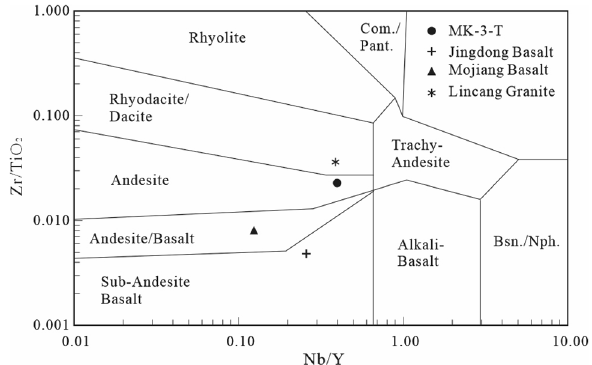
Figure 9. Zr/TiO 2 vs. Nb/Y shows typical volcanic rock types (modified after reference 51 ). The original lithology of the sample is andesite tuff ( Com comendite, Pant pantellerite, Bsn basanite, Nph